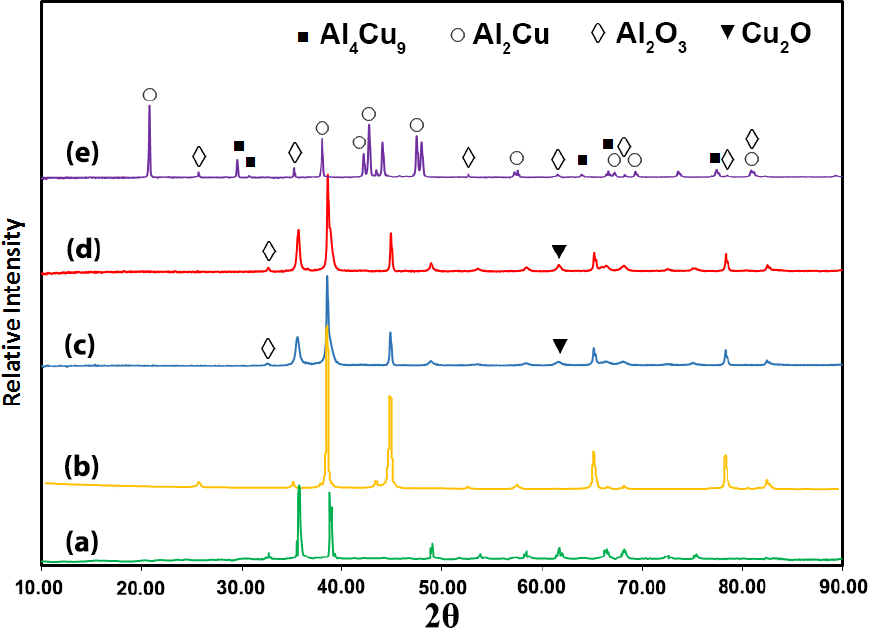
Figure 4. XRD patterns of starting materials ( a ) copper oxide, ( b ) aluminium, and mixed powders after different milling times of ( c ) 30 (C1), ( d ) 90 (C2), and ( e ) 150 (C3) min.